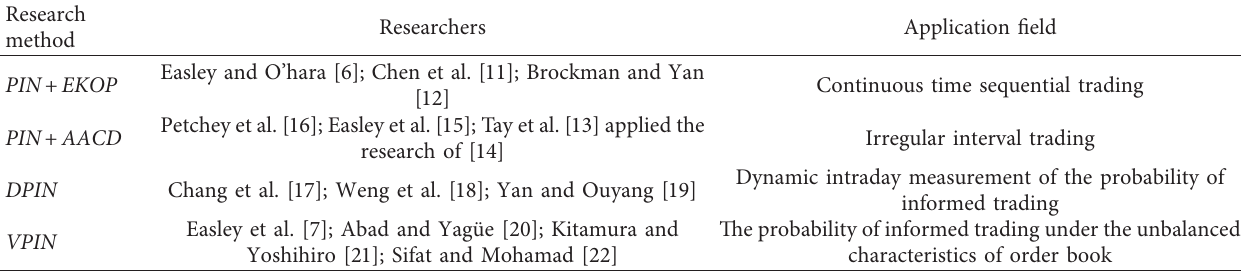
Table 1: Related research results of the probability of informed